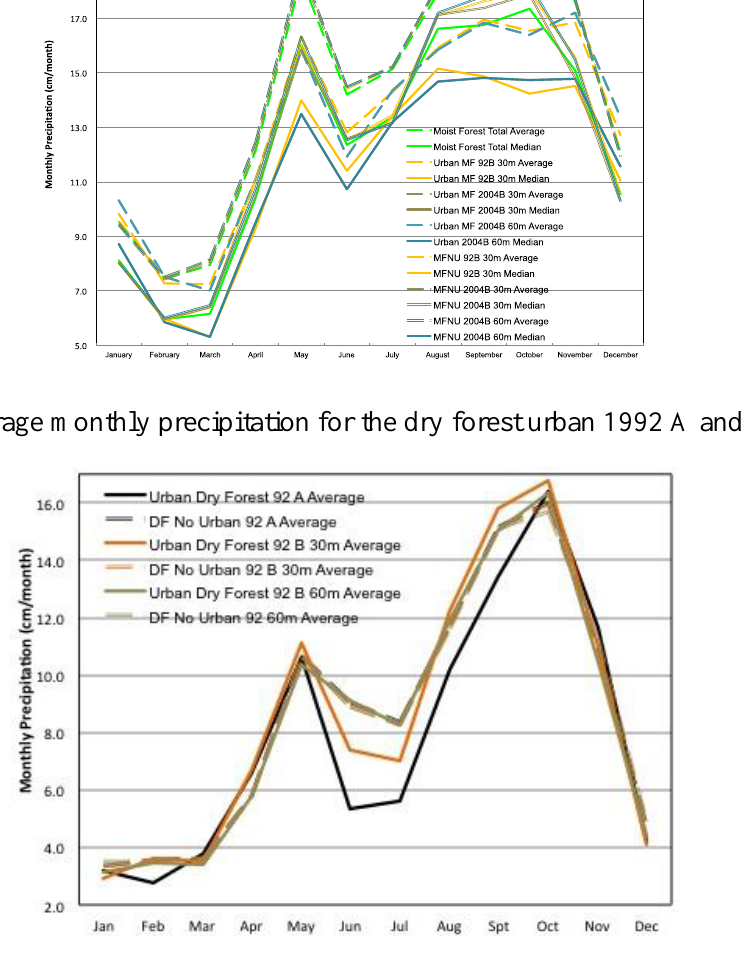
Figure 11. Median monthly precipitation for the dry forest urban 1992 A and